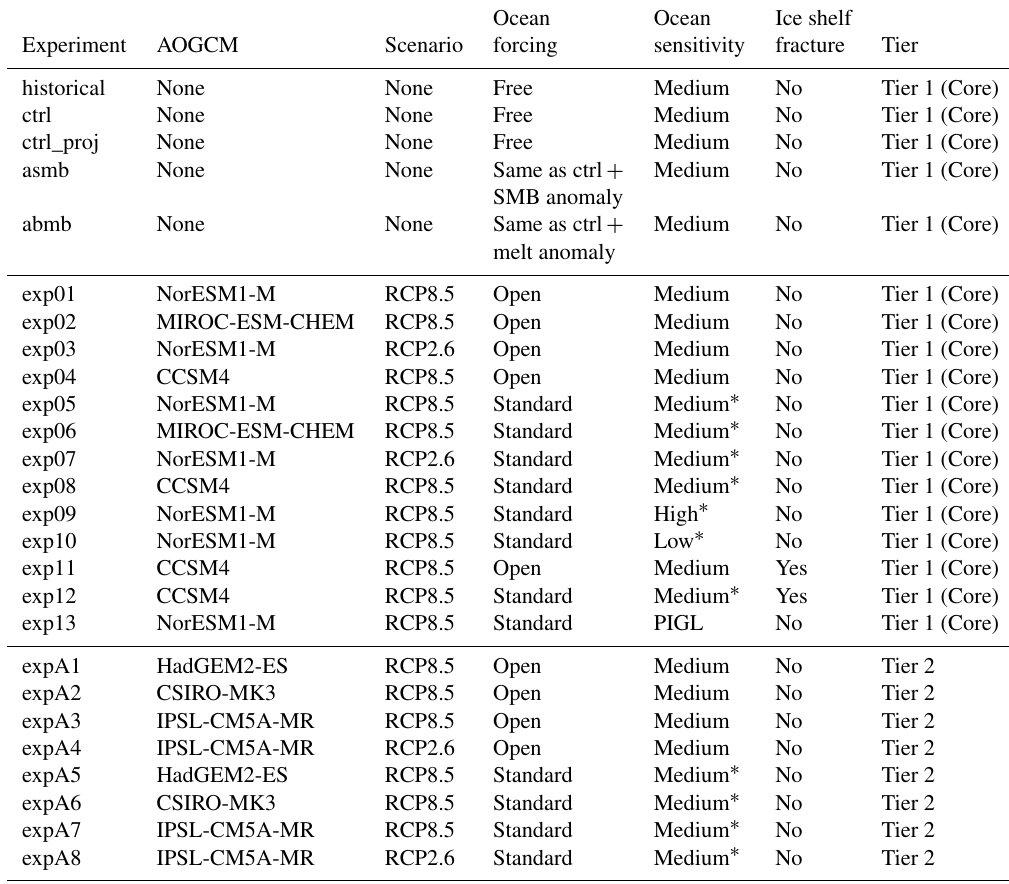
Table 1. List of ISMIP6-Antarctica projections for the core (Tier 1) and Tier 2 experiments based on CMIP5